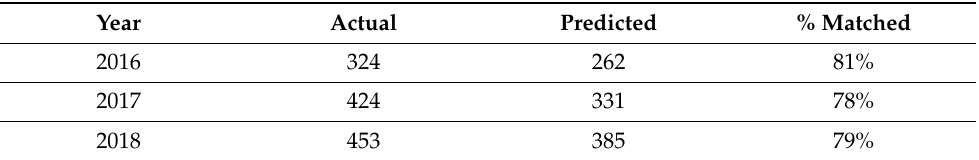
Table 2. Actual number of infected sites and the number of infected sites predicted from the simulation with β = 0.000021 and µ =